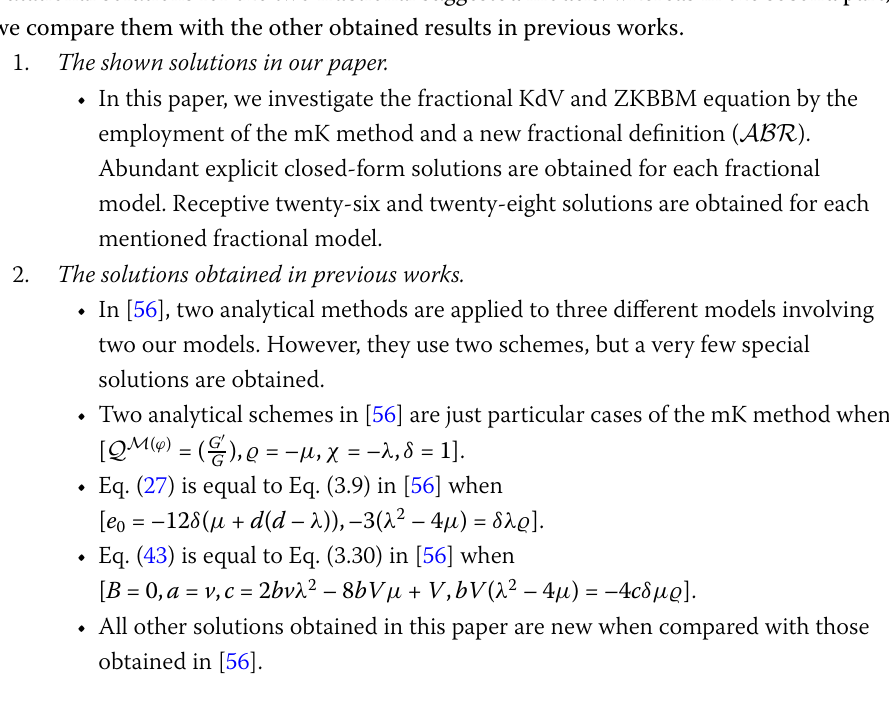
, δ = –9, λ = 3, m = 1, n = 1, χ = 0, (cid:4) = 1] [ α = 1 2